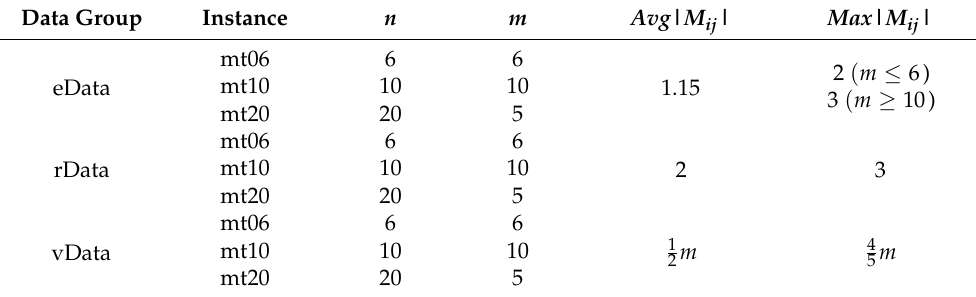
Table 4. Benchmark problem instances.